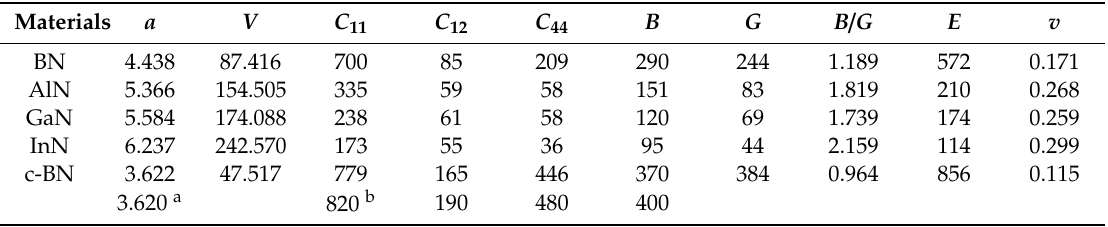
Table 1. The lattice constants (Å), volumes of the conventional cell (Å 3 ), elastic parameters (GPa), B , G , E (GPa) and Poisson’s ratio v of Pm −3 n XN and c-BN.